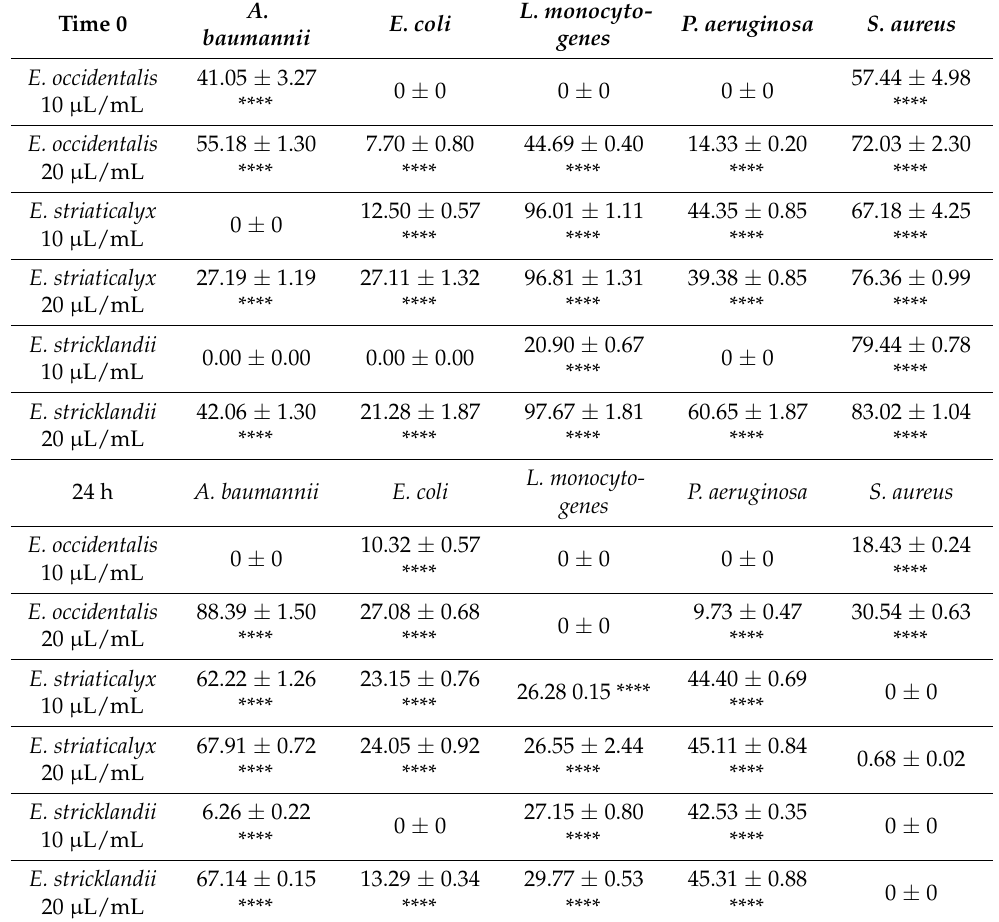
Table 7. Percent inhibition of two doses of the EOs on biofilm metabolic activity of A. baumannii , E. coli , L. monocytogenes , P. aeruginosa and S. aureus , at 0 and 24 h. Time 0